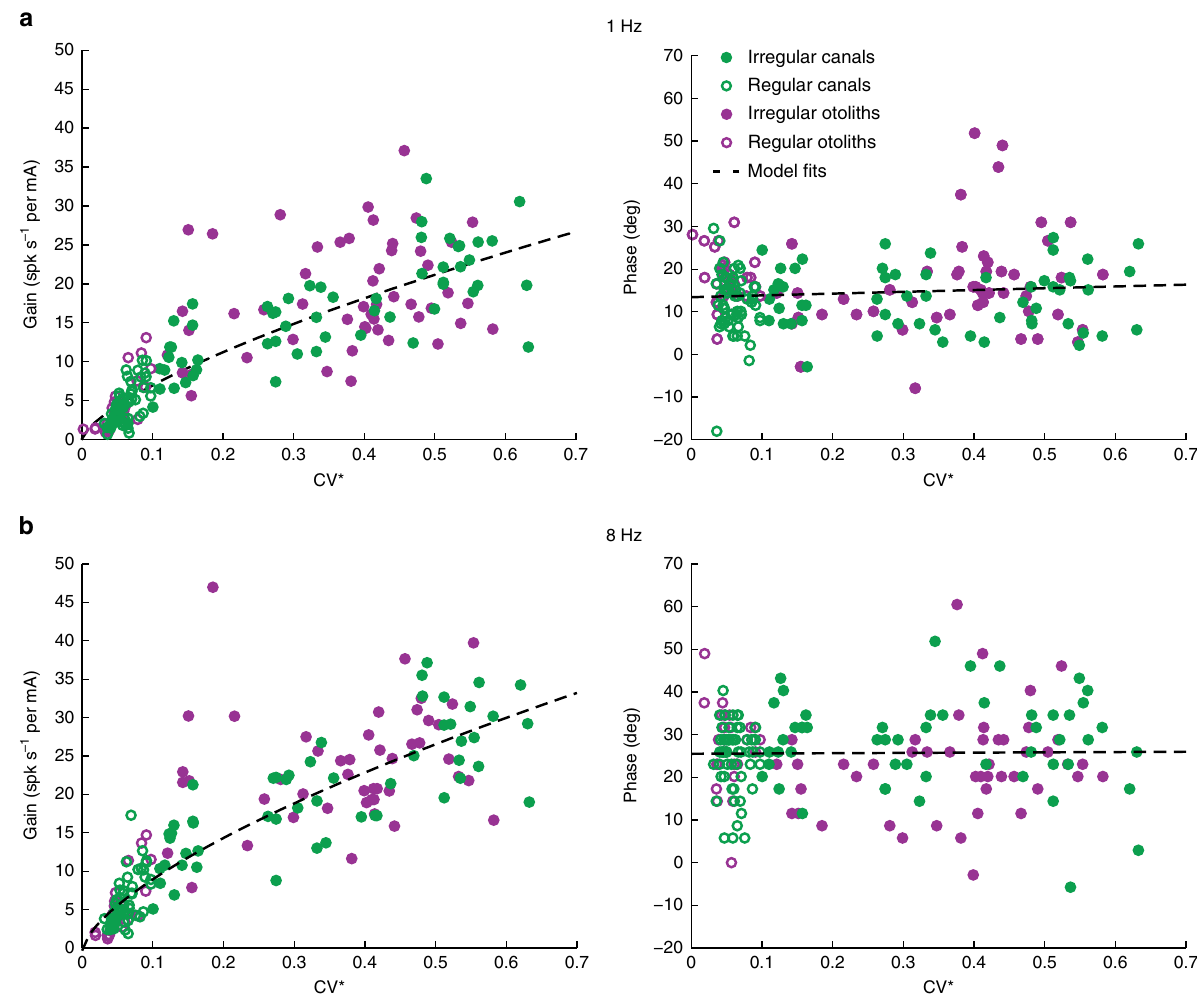
Fig. 3 Comparison of canal and otoliths afferent responses to sinusoidal GVS. Gain (left) and phase (right) of canal (green circles, N = 119) and otolith (purple circles, N = 84) afferents to 1 Hz ( a ) and 8 Hz ( b ) sinusoidal stimulation as a function of the resting discharged variability, quanti fi ed as CV*. Dashed lines depict estimated power-law fi ts of gain (1 Hz: a = 30.2 [c.i. 27.1, 33.2], b = 0.64 [c.i. 0.6, 0.7]; 8 Hz: a = 41.3 [c.i. 37.7, 44.9], b = 0.62 [c.i. 0.6, 0.7]; left plots) and linear fi ts of phase (1 Hz: a = 9.7 [c.i. 4.8, 14.7], b = 9.7 [c.i. 8.3, 11.1]; 8 Hz: a = 0.7 [c.i. − 7.2, 8.6], b = 25.5 [c.i. 23.2, 27.8]) to the combined canal and otolith afferent data set. c.i.: con fi dence